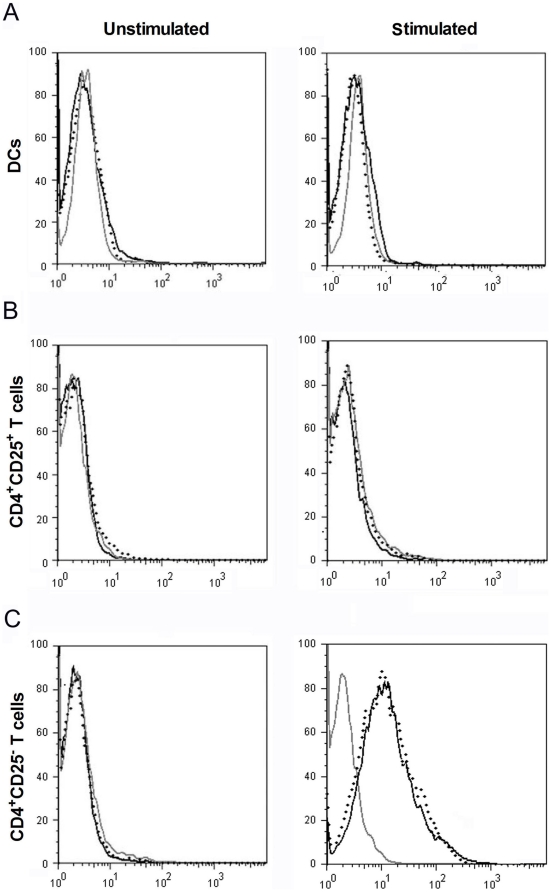
Expression of a binding partner for Tim-1 on CD4+ effector T cells.Unstimulated or 72 h LPS (100 ng/ml)-stimulated DCs (A), anti-CD3, anti-CD28 mAbs and IL-2 (200 IU/ml)-stimulated CD4+CD25+Tregs (B) and anti-CD3 (2 µg/ml), CD28 (1 µg/ml) mAbs-stimulated CD4+CD25− T cells (C) were stained with 5 µg/ml control human IgG1 (gray line) or Tim-1-Fc (black line), followed by anti-human IgG1 Fc-FITC and subjected to FCM analysis. Anti-Tim-4 mAb (10 µg/ml, dotted line) were added to block the possible Tim-1-Tim-4 interaction.